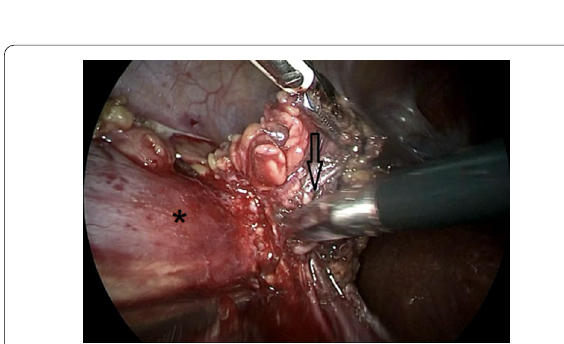
Fig. 4 Laparoscopic resection of the capsular mass with a safe margin. The black star shows normal renal parenchyma, and the arrow shows the mass being resected